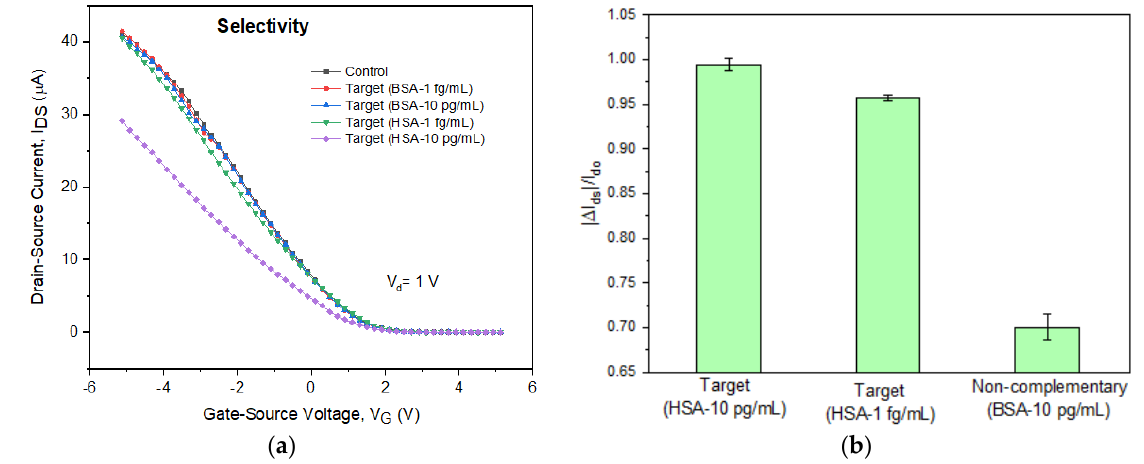
Figure 11. Selectivity detection: ( a ) toward HSA targets (1 fg/mL and 10 pg/mL) and non-complementary BSA targets (1 fg/mL and 10 pg/mL); ( b ) bar graph of the gate-source voltage response to specific targets and non-specific binding (using CoMoCAT SWCNTs).